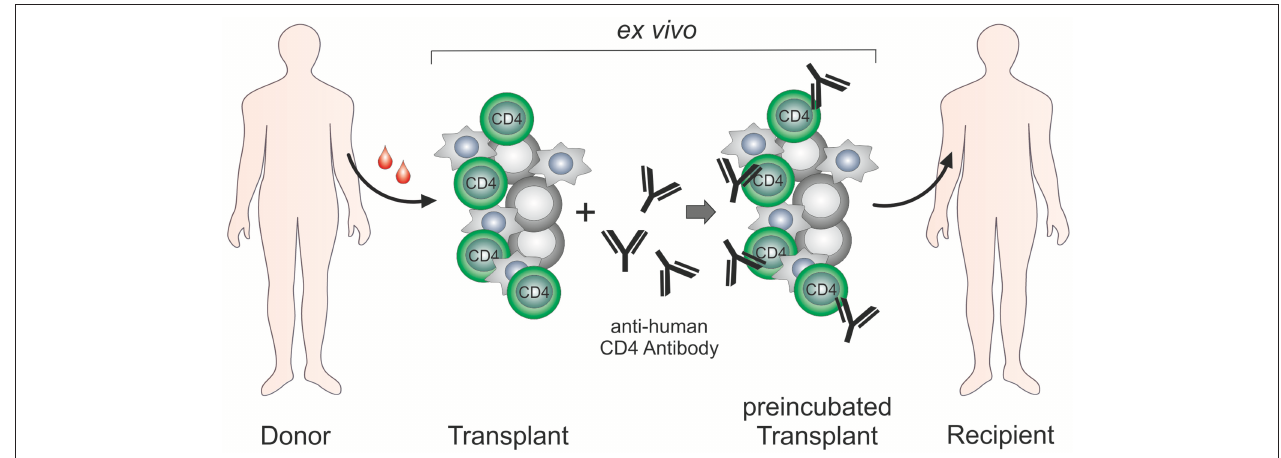
FIGURE 2 | Ex vivo treatment of hematopoietic stem cell/immune cell grafts by anti-human CD4 antibody